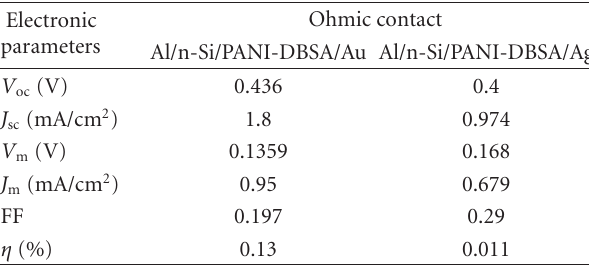
Table 2: Photovoltaic characteristic parameters of Al/n-Si/PANI- DBSA herterojunctions using Au or Ag as Ohmic